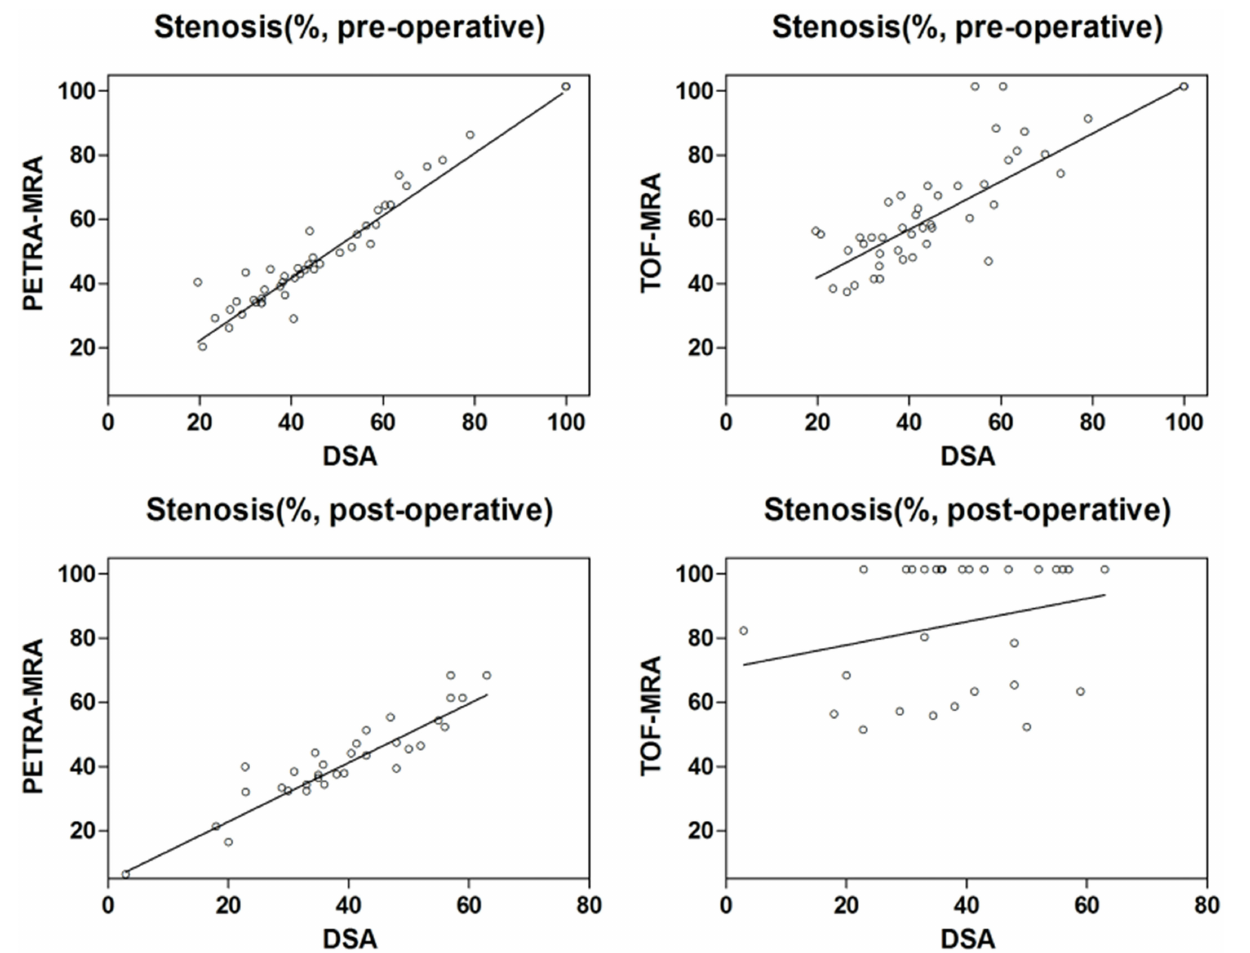
FIGURE 3 | Spearman correlation plots for the comparisons of stenosis measurements between PETRA-MRA/TOF-MRA and reference standard DSA. For pre-intervention evaluation, there was a better correlation in measuring stenosis between PETRA-MRA ( r = 0.96, CV = 4.6%) and DSA than between 3D-TOF-MRA ( r = 0.85, CV = 11.0%) and DSA; For post-intervention evaluation, PETRA-MRA had an excellent agreement with DSA ( r = 0.90, CV = 5.4%), while 3D-TOF-MRA had a poor agreement with DSA ( r = 0.26, CV = 20.9%).